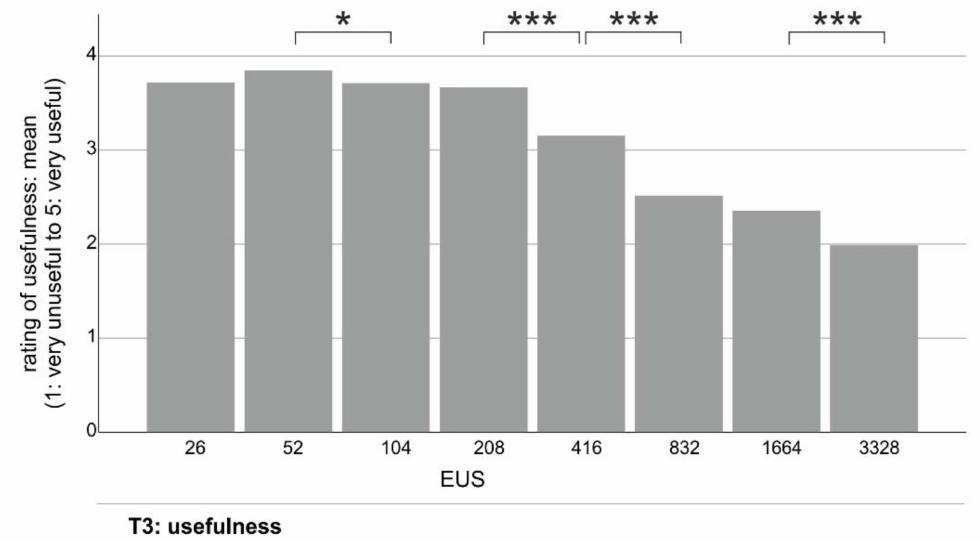
Figure 6. Participants’ ratings concerning the usefulness of particular EUSs for indicating the main characteristics of the phenomenon presented on the symbol map, * p < 0.05, *** p ≤